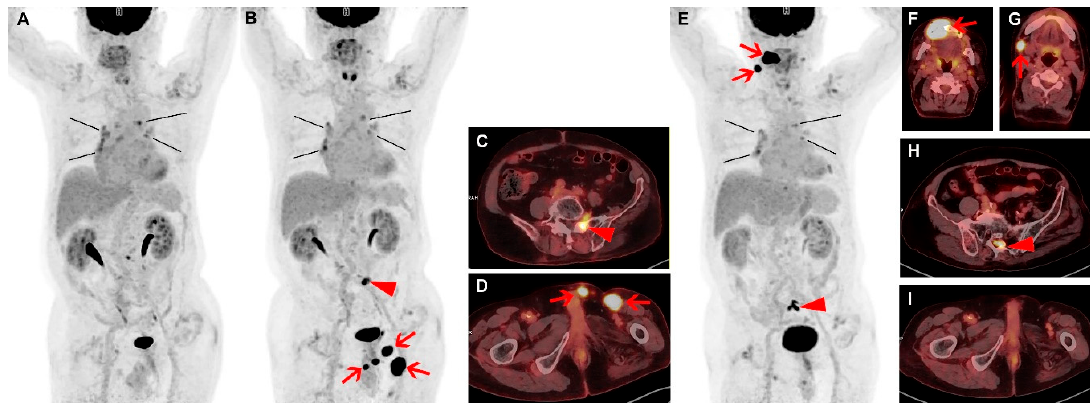
Figure 1. A 67-year-old male patient was diagnosed with diffuse large B-cell lymphoma (DLBCL) and had right orchiectomy followed by 8 cycles of rituximab, cyclophosphamide, hydroxydaunorubicin,